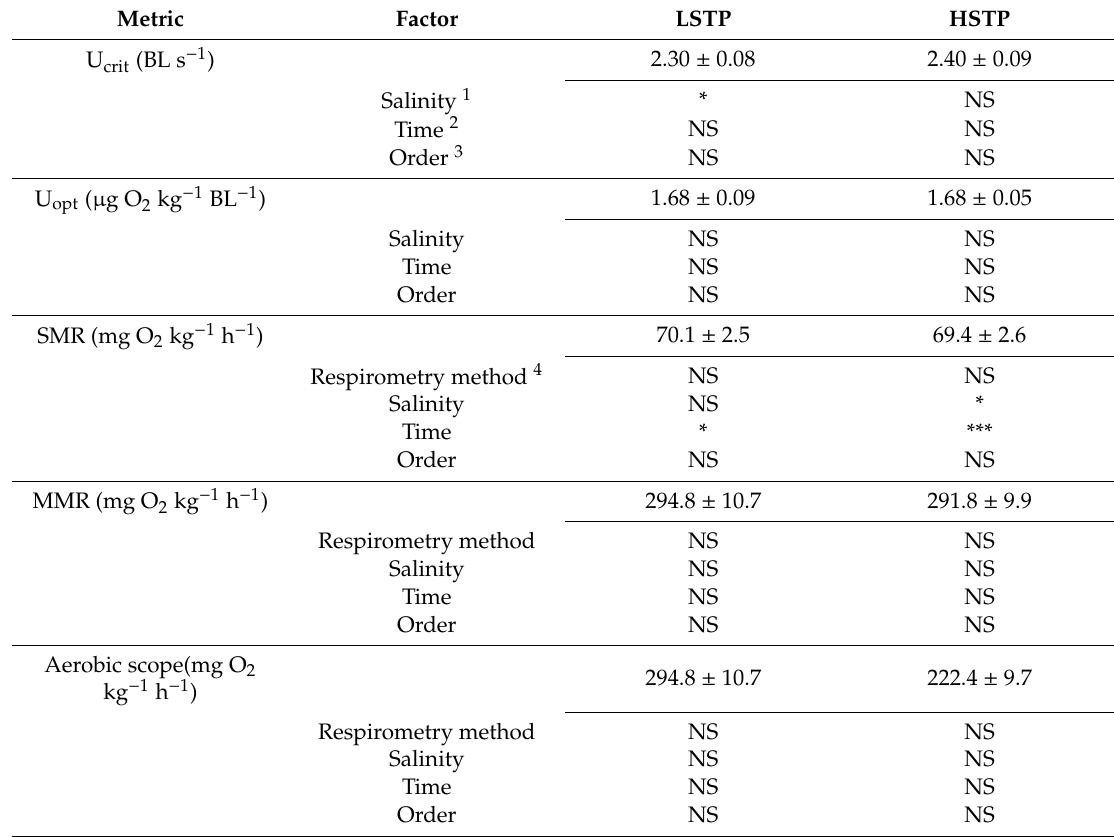
Table 1. Swimming performance and metabolic rates in relation to salinity of European perch ( P. fluviatilis ) from a low salinity tolerance population (LSTP) and a from high salinity tolerance population (HSTP). The total sample size was 16, with eight individuals being used repeatedly at both salinities. Critical and optimal swimming speeds (U crit and U opt , respectively), where swimming speed is given in body lengths (BL) s − 1 , standard metabolic rate (SMR), maximum metabolic rate (MMR), and aerobic scope are ´given by the overall means across the di ff erent response factors for each population ± SE. The statistics are from general linear models (U crit and U opt ), and linear mixed models (SMR, MMR, and AS). “*”, “***”, and “NS” represent p < 0.05, p < 0.001, and not significant, respectively. Metric Factor LSTP HSTP U crit (BL s − 1